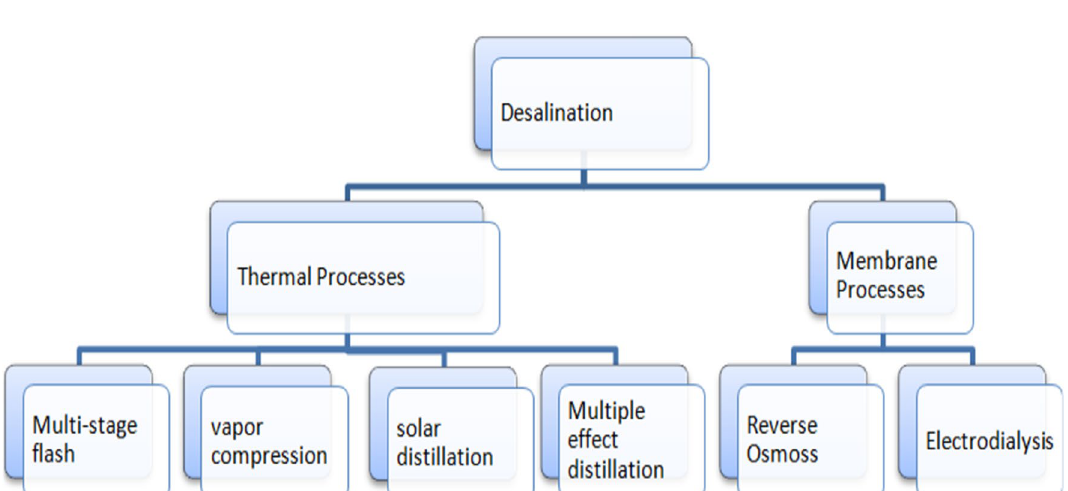
Fig. 2 Processes of a temperature difference. As shown in Fig. 3b, a third chan- nel is introduced by an additional impermeable film that is located on the permeate side of the membrane. Since the permeate outlet is located at the highest module position, the gap between the membrane and the impermeable film fills with permeate during operation and is therefore referred to as the permeate gap (PG) or liquid gap (LG) (Mahmud et al. 2000; Schofield et al. 1987).